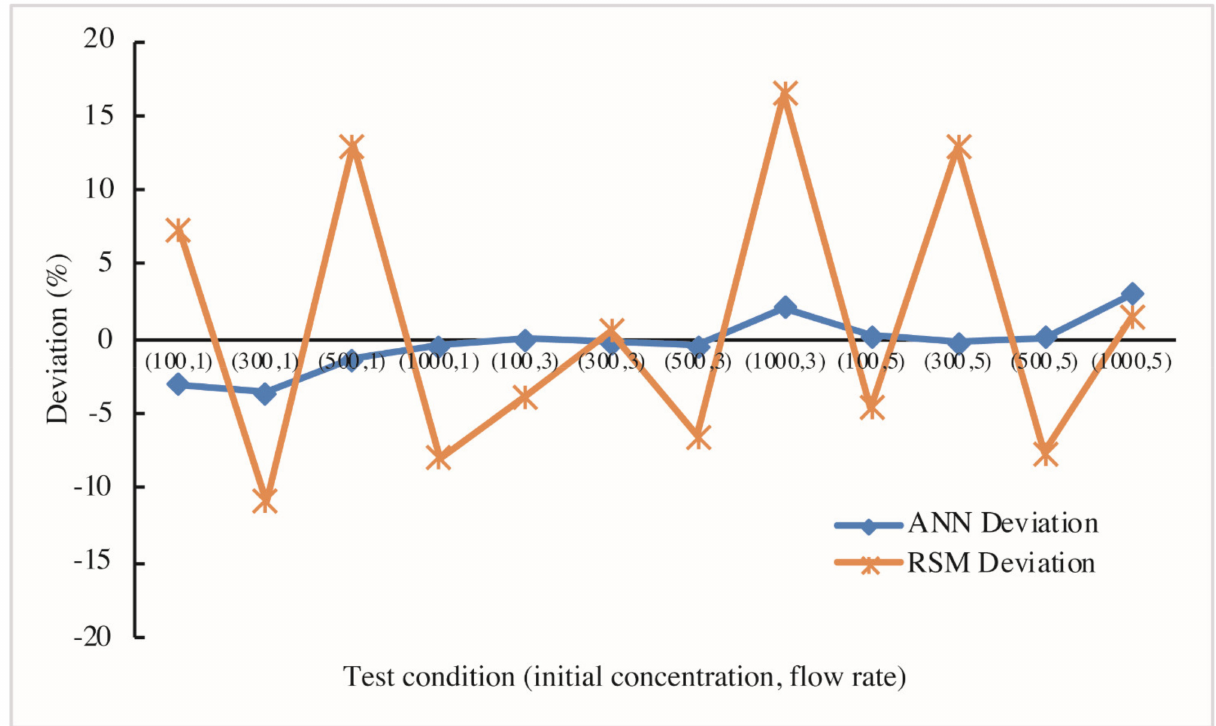
Figure 15. Comparison of deviations of RSM and